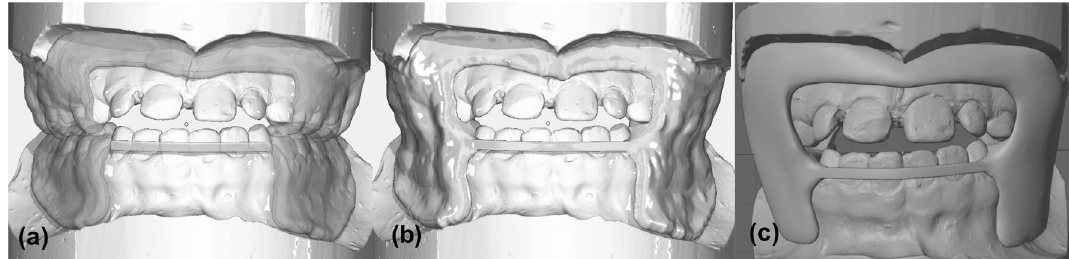
Figure 1. Stages of digital construction. ( a ) The maxillary and mandibular parts of each CAD/CAM function regulator 3 (CAD-FR3) were initially designed separately in the program OnyxCeph. ( b ) The two parts